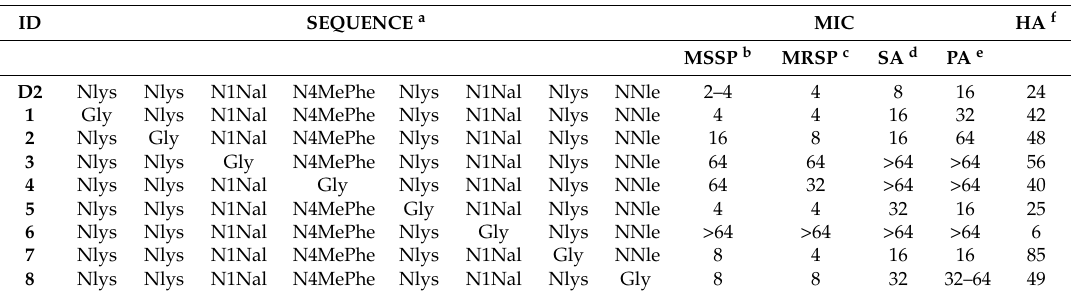
Table 1. Structures, antimicrobial activity (MIC, µ g/mL) and hemolytic activity (% at 150 µ M) of eight analogues of D2 resulting from